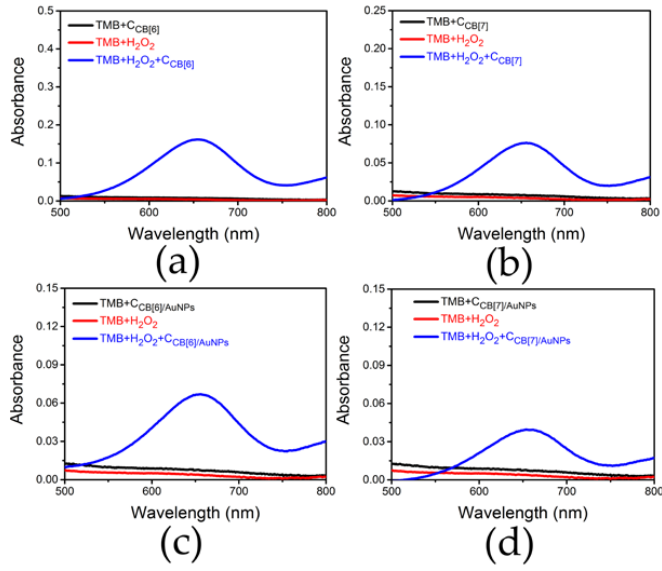
Figure 4. UV-vis spectra of different TMB system with ( a ) C CB[6] ; ( b )C CB[7] ; ( c ) C CB[6]/AuNPs ; ( d ) C CB[7]/AuNPs .